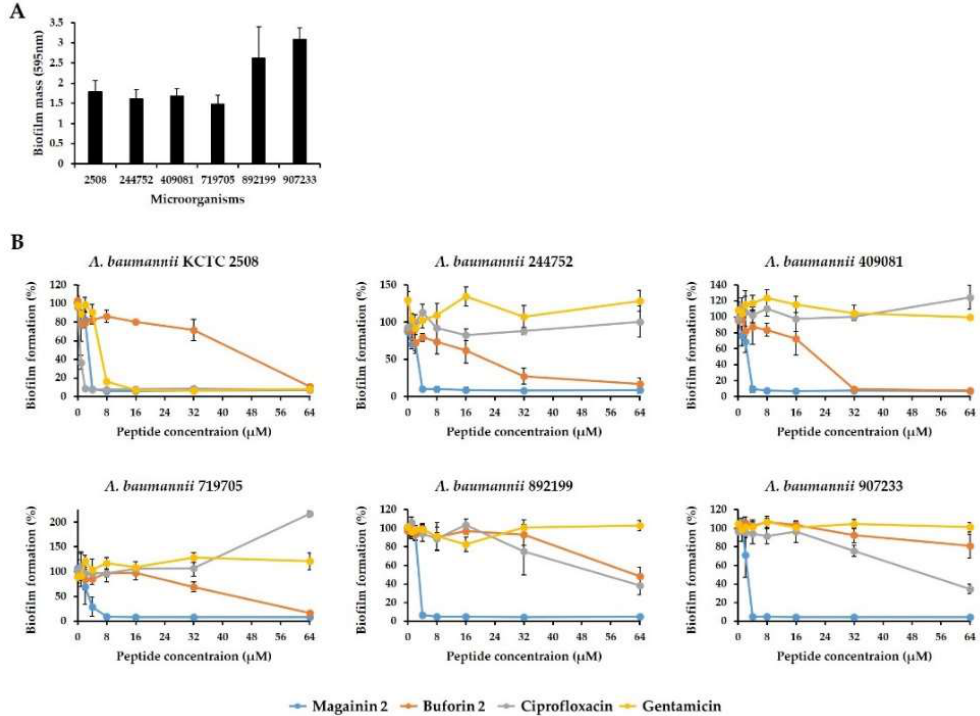
Figure 4. Effect of Acinetobacter baumannii biofilm formation by magainin 2. ( A ) Quantitative measurements of biofilm formation using crystal violet staining. ( B ) Inhibitory effect of peptides on biofilm formation. Antibiotics (ciprofloxacin and gentamicin) and buforin 2 were used as controls.